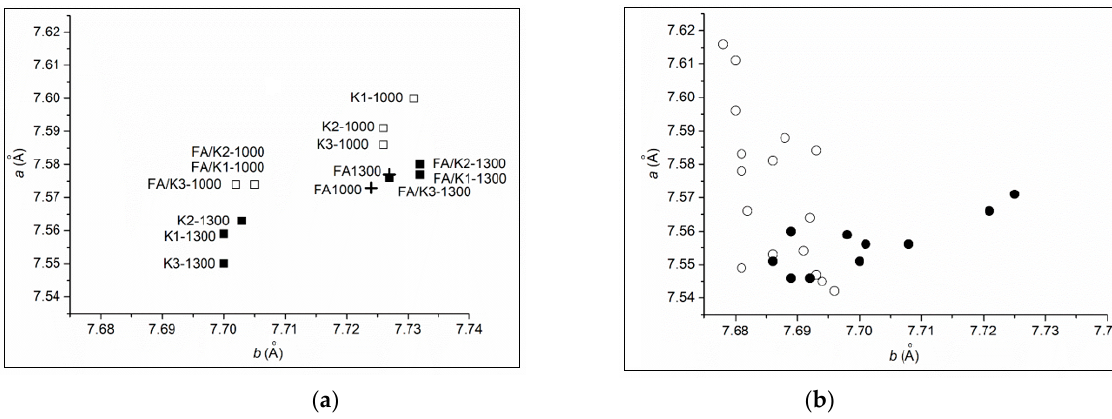
Figure 5. Structural relation of mullite lattice parameters a and b of: ( a ) sintered in this work samples and ( b ) reported in the literature [40] without iron substitution ( ○ ) and with substitution Fe (•).